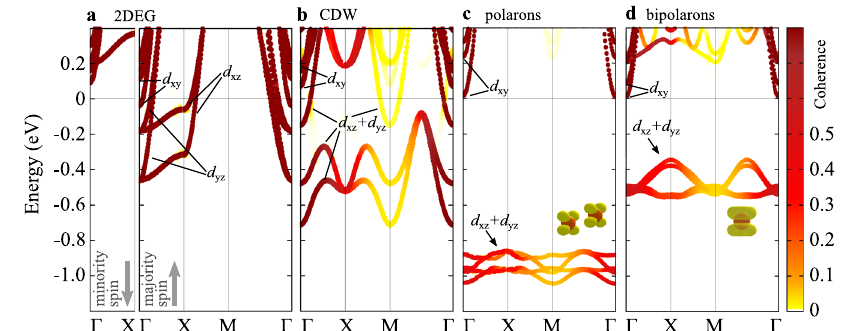
Fig.4|Energybandstructures. EnergybandsoftheTaO 2 surfaceasobtainedby modelingseparatelythe2DEG( a ),CDW( b ),sub-surfacesingle-electronpolarons